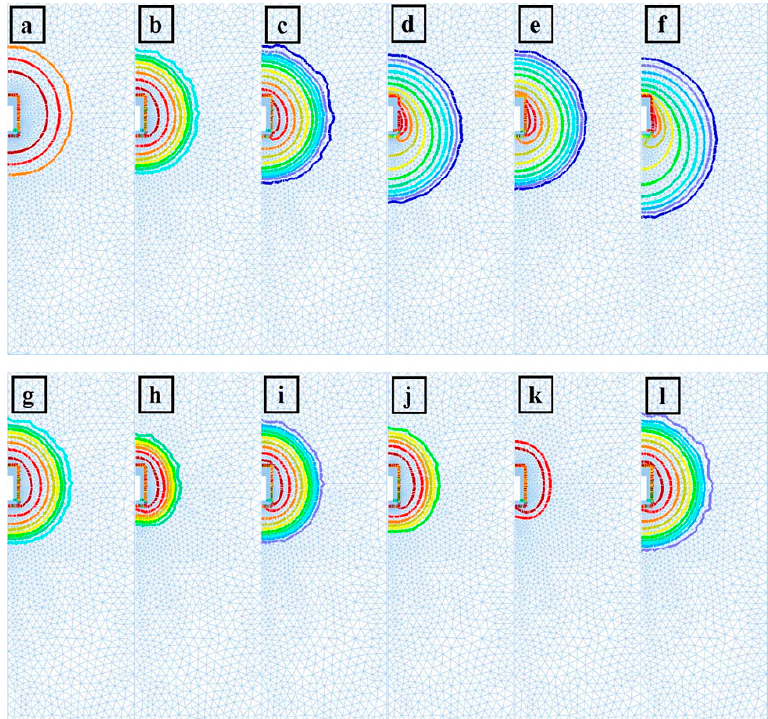
Figure 5. Images showing the wetting front for different soil textures after 12 h (( a ) clay, ( b ) clay loam, ( c ) loam, ( d ) loamy sand, ( e ) sandy loam, ( f ) sand, ( g ) sandy clay loam, ( h ) sandy clay, ( i ) silt, ( j ) silty clay loam, ( k ) silty clay, ( l ) silty loam).